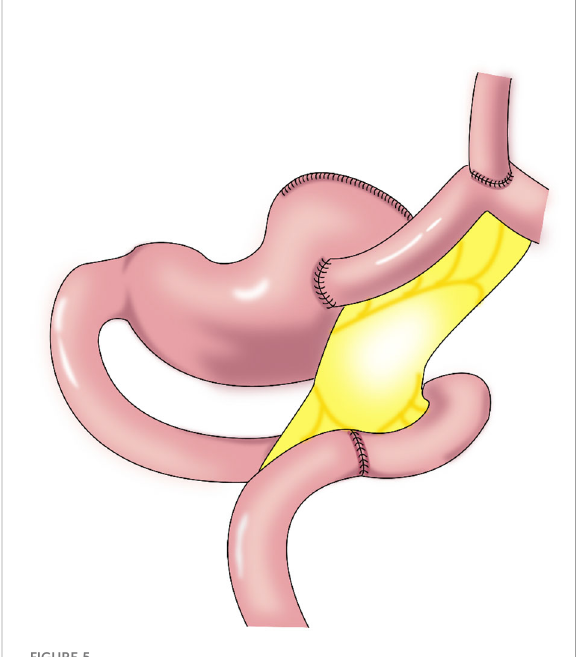
FIGURE 5 Jejunal interposition: a segment of jejunum is inserted between the esophagus and the remnant stomach to construct an anti- re fl ux barrier. This procedure takes advantage of intestinal peristalsis and the tolerance of the jejunum to acidic gastric juice and alkaline digestive juice.